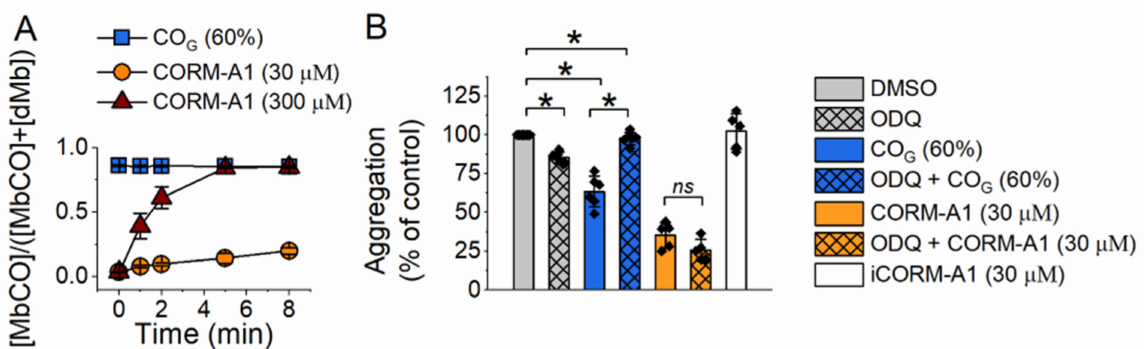
Figure 1. Comparison of the effects of CO delivered by CO-saturated buffer or released by CORM-A1 on platelet aggregation. ( A ) Time and concentration–dependent changes in fraction of carboxy-Myoglobin (MbCO), after mixing of CO-saturated buffer (CO G ; 60%) or CORM-A1 with deoxy-Myoglobin (dMb, 66 µ M). ( B ) Effects of ODQ (10 µ M) on collagen (2 µ g/mL)– induced aggregation of WP treated with CO G (60%) or CORM-A1 (30 µ M); effect of inactive CORM-A1 (iCORM-A1; 30 µ M). Data represent means +/-SD from at least three independent experiments. * p <